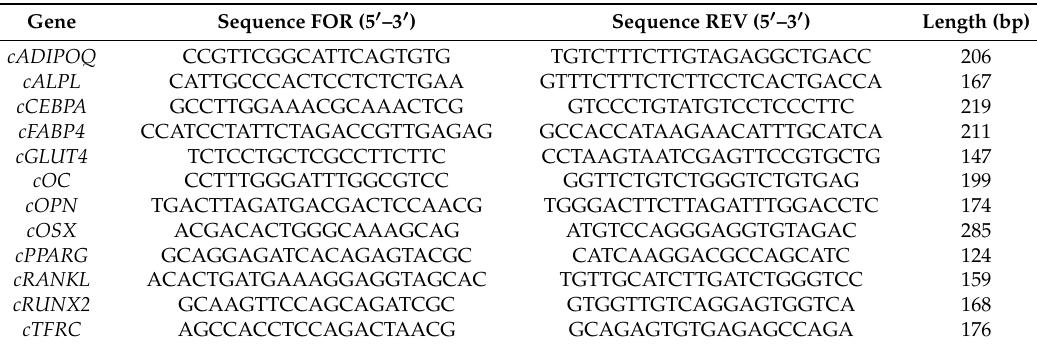
Table 3. Canine primer